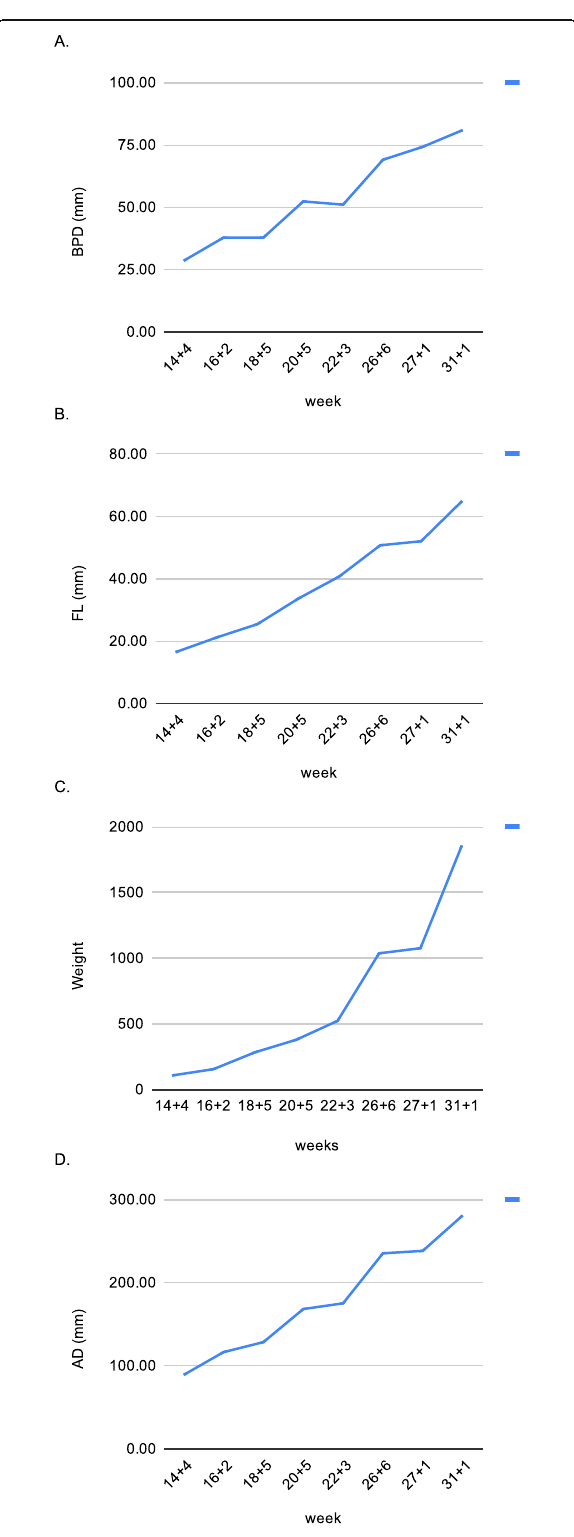
Fig. 1 Estimates by ultrasound of fetal growth. a Biparietal diameter (BPD). b Femur length (FL). c Fetal weight. d Abdominal diameter